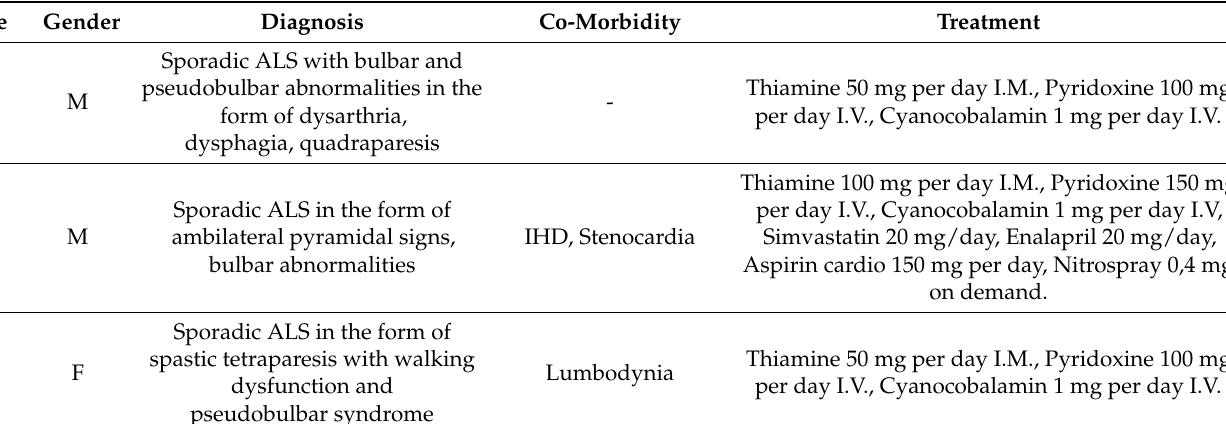
Table 1. Saliva donor details and clinical